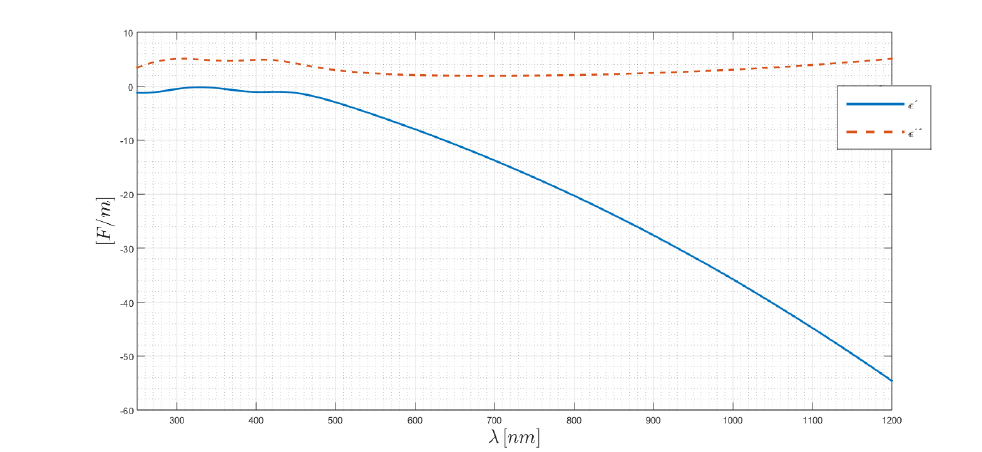
Figure A3. Gold complex dielectric function (solid blue line: real part; dashed red line: imaginary